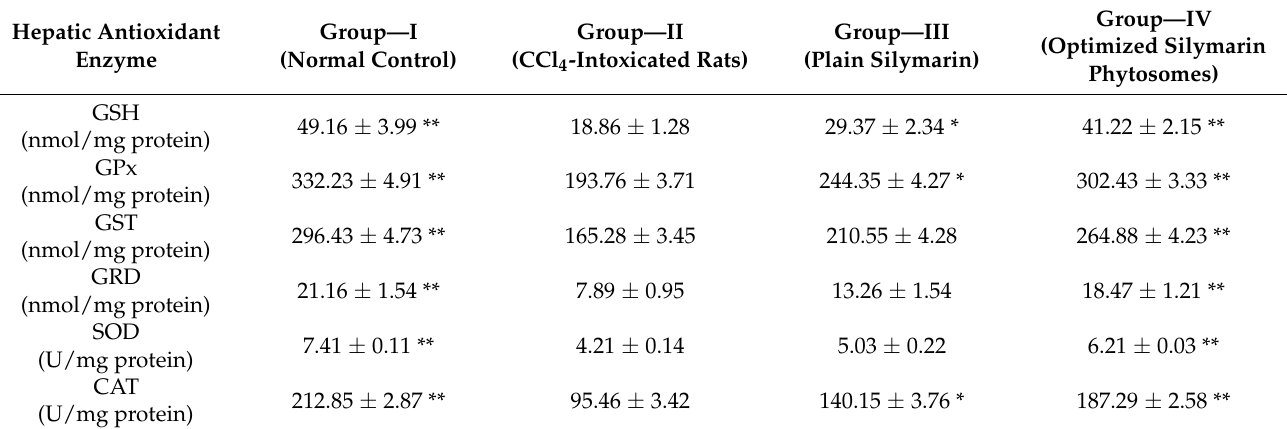
Table 4. Effect of plain silymarin and optimized silymarin phytosomes on antioxidant